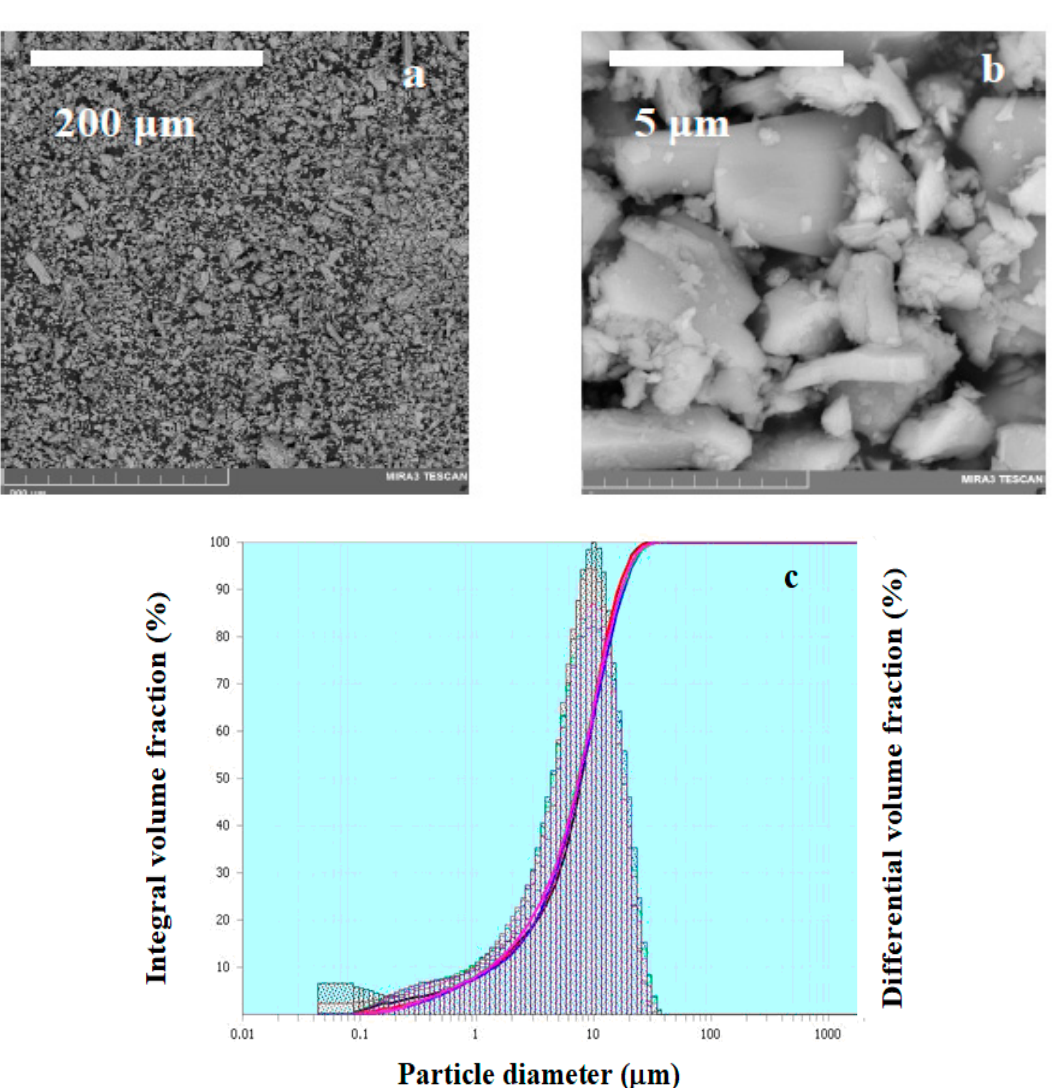
Figure 4. SEM image of NaV 3 O 8 sample with different resolutions, ( a ) 500x and ( b ) 20.3kx; ( c ) particle size distribution in NaV 3 O 8 samples obtained by solid state ( c ).